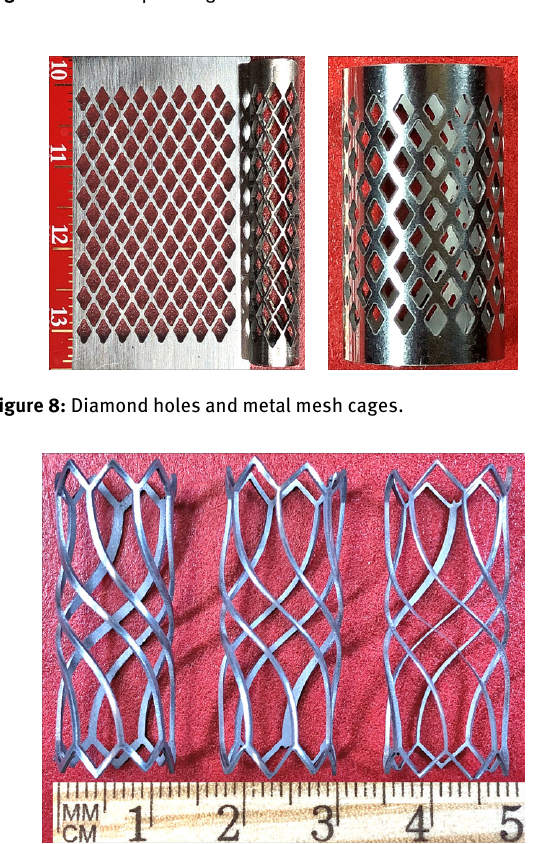
steel plate 0.4 mm thick, a titanium mesh cage by machin- ing with the Rotary Axis the same hole pattern onto a 6 mm OD titanium tube. On the right is a nitinol mesh cage with an OD of 14.8